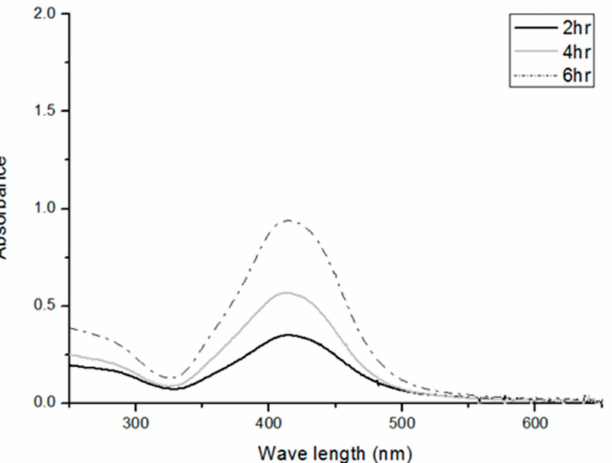
Figure 8. UV-Vis absorbent spectra of Ag particles as related to reaction time (2, 4, and 6 h) and incident UV-Vis wavelength (250–650 mm).